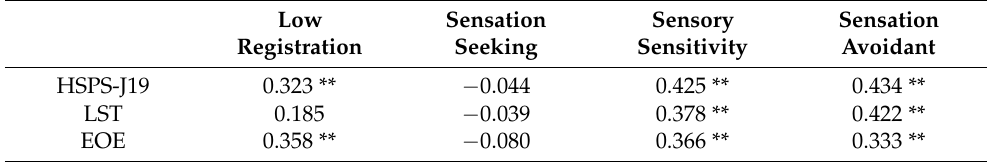
Low Registration